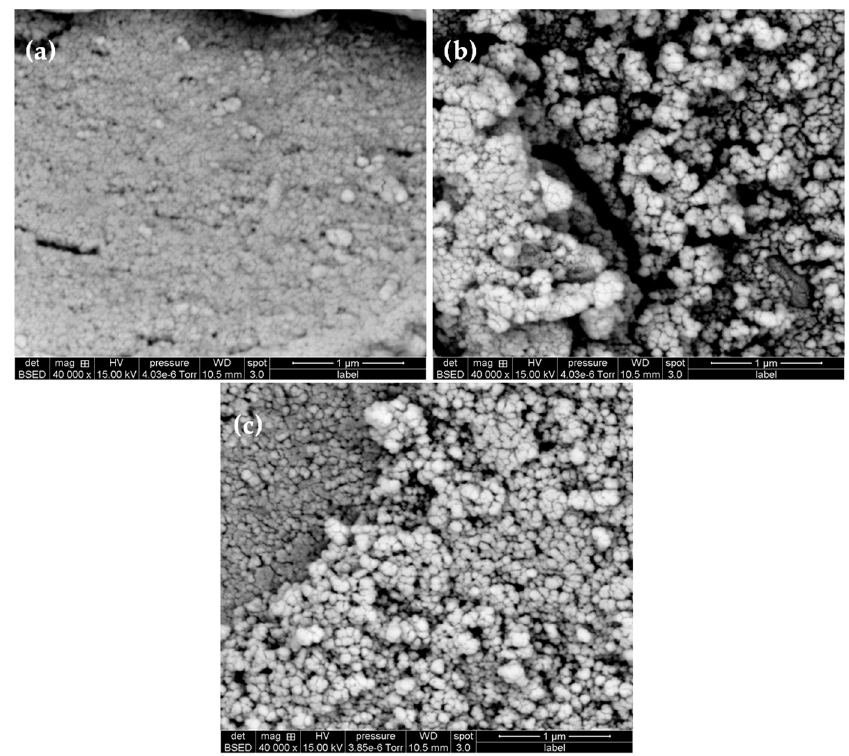
Figure 7. SEM images of ( a ) empty particles and nanocapsules containing ( b ) orange essential oil and ( c ) bergamot essential oil.